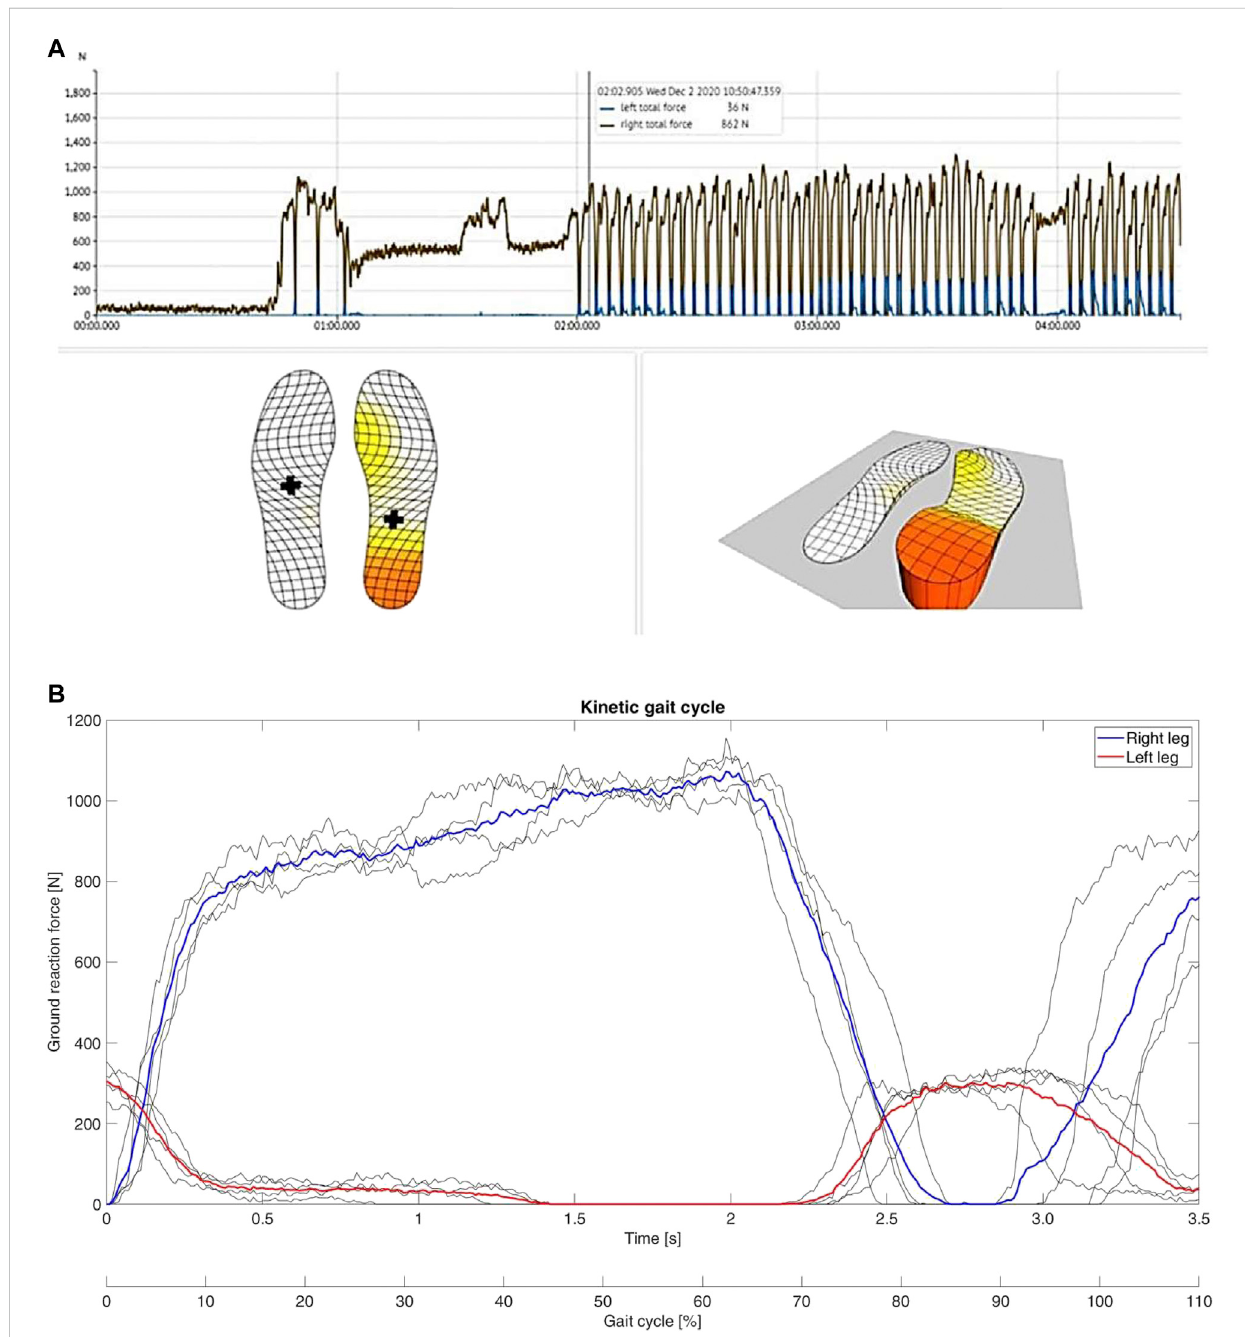
FIGURE 3 Resultsofmotiondataobtainedfrominsoles. (A) :Screenshotofthemeasurementoftheinsolesshortlyaftersurgery.Therightfootisclearlyloaded withalmostthefullweightofthebody. (B) :Typicalcurvesofthegaitcycleduringthe fi rstphysiotherapysessionofthepatientaftersurgery.Thecurvesdo not show the typical bicuspid shape and the ground reaction force is strongly in favour of the right leg. Of interest, the left leg is loaded with up to approximately 35 kg during the cycles, although weight-bearing restriction of maximum 20 kg was prescribed by the trauma